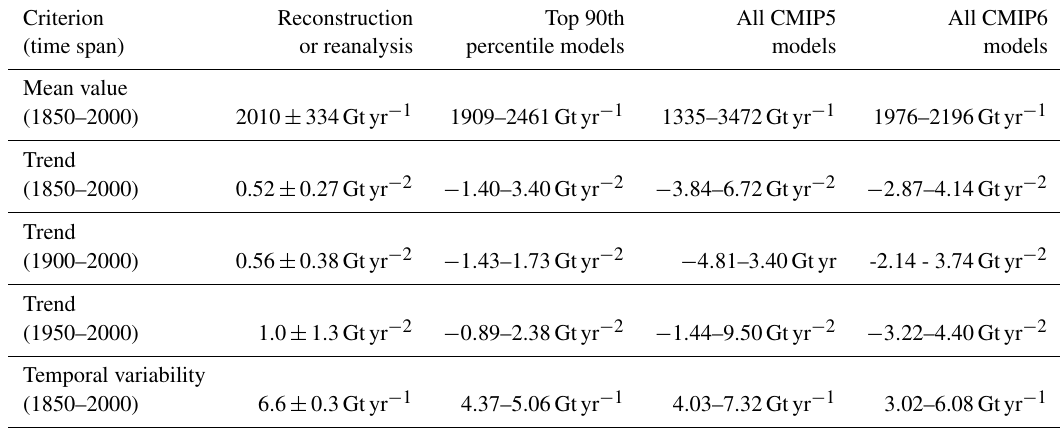
Table 1. List of ranges of values for the three temporal criteria for the top 90th percentile models, all CMIP5 models, and all CMIP6 models as well as the values and uncertainties for the